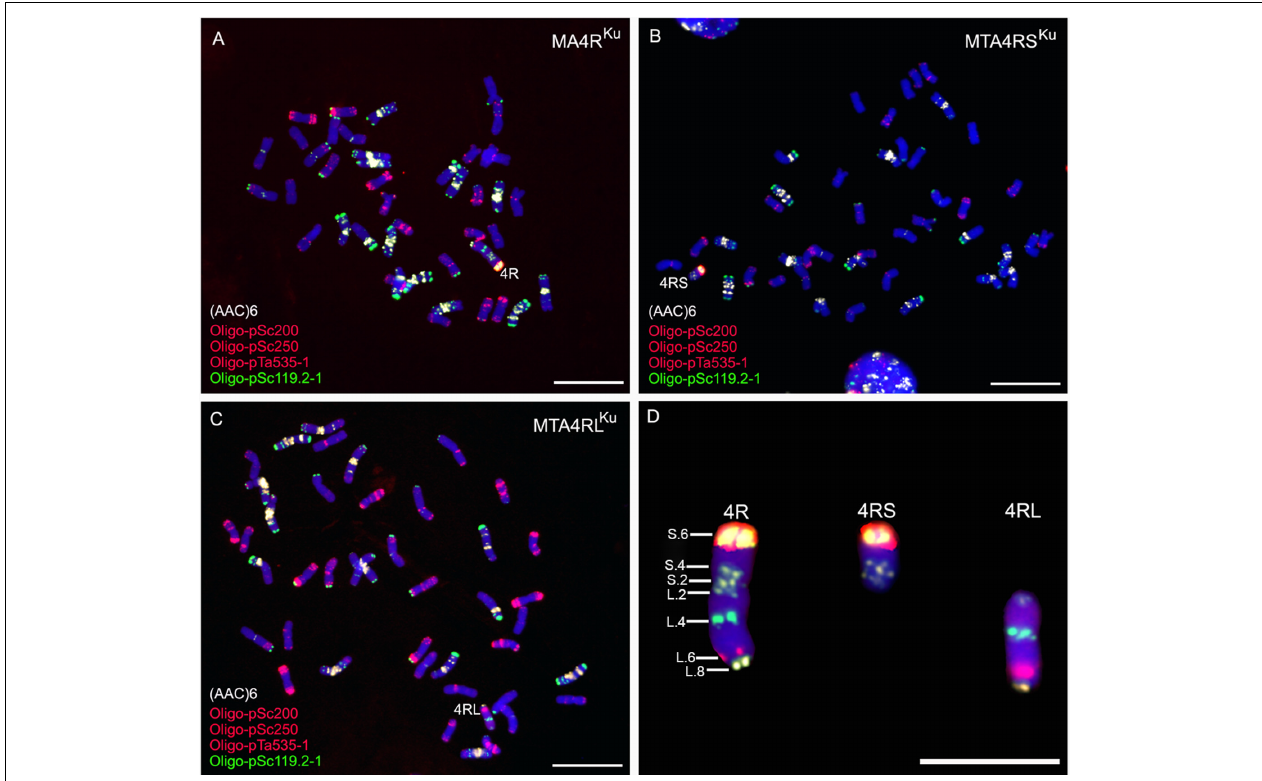
FIGURE 1 | ND-FISH analysis using probes Oligo-pSc119.2-1 (green), Oligo-pTa535-2 (red), Oligo-pSc200 (red), Oligo-pSc250 (red) and (AAC) 6 (white) to identify MA4R Ku , MTA4RS Ku and MTA4RL Ku . (A) Line MA4R Ku contains 42 wheat chromosomes and a 4R chromosome. (B) Line MTA4RS Ku contains 42 wheat chromosomes and a 4RS arm. (C) Line MTA4RL Ku contains 42 wheat chromosomes and a 4RL arm. (D) Cut-pasted 4R Ku chromosome, 4RS Ku arm and 4RL Ku arm. A new FISH map was constructed according to Oligo-pSc119.2-1, Oligo-pTa535-2, Oligo-pSc200, Oligo-pSc250 and (AAC) 6 signals. Chromosomes were counterstained with DAPI (blue). Scale bar is 10 µ